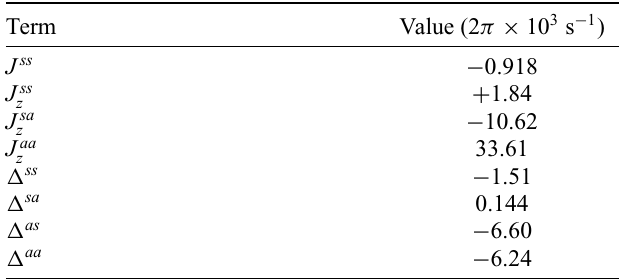
TABLE II. Computed values of the interaction coefficients